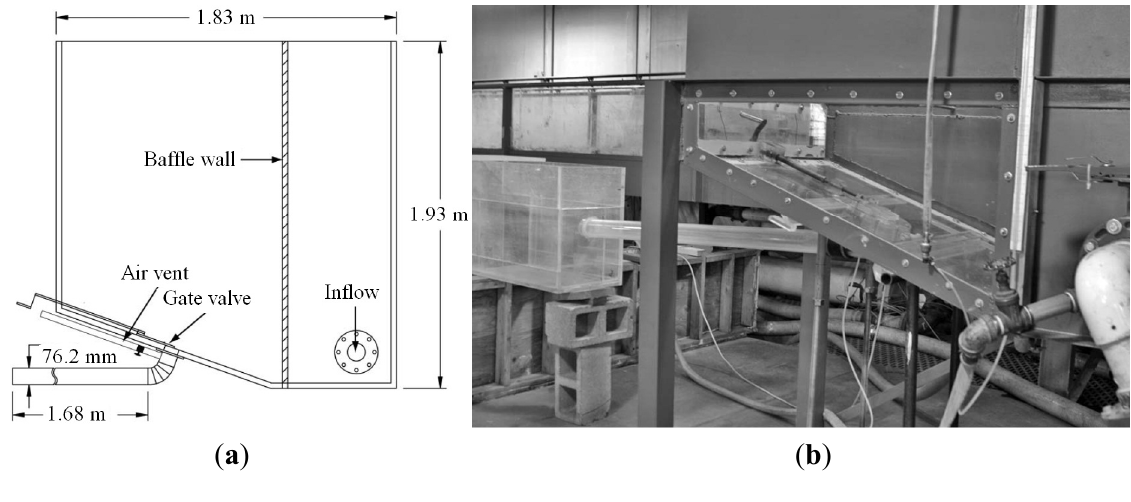
Figure 2. ( a ) Schematic of lab-scale low-level outlet works; and ( b ) experimental set-up after